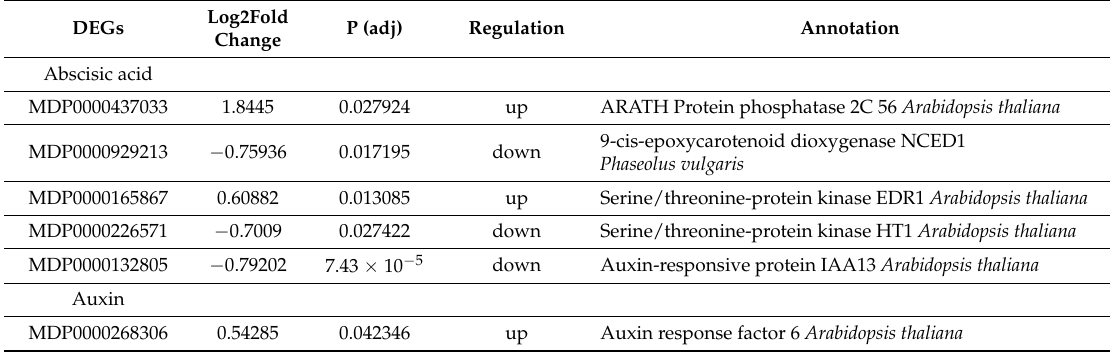
Table 2. DEGs related to plant hormones expressed in pre ‐ ripening (HY_4th vs. HY_3rd) group.